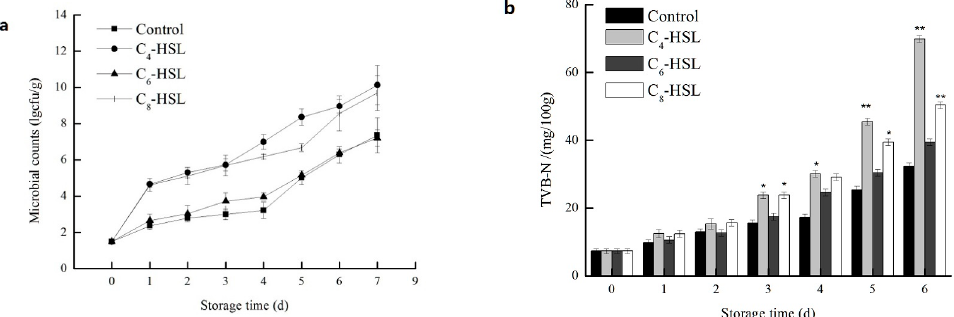
Figure 6. The effects of C 4 -HSL(20 μ M), C 6 -HSL(20 μ M) and C 8 -HSL(20 μ M) on ( a ) microbial counts; and ( b ) TVB-N production in turbot blocks stored at 4 °C. Data were presented as the mean ± standard deviation ( n = 6; * p < 0.05; ** p < 0.01).